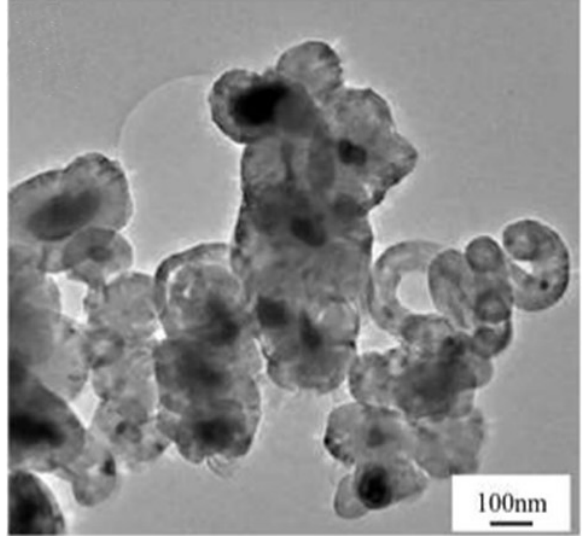
Figure 23. Carbon nano onions deposited on the deactivated catalyst surface in the CDM process